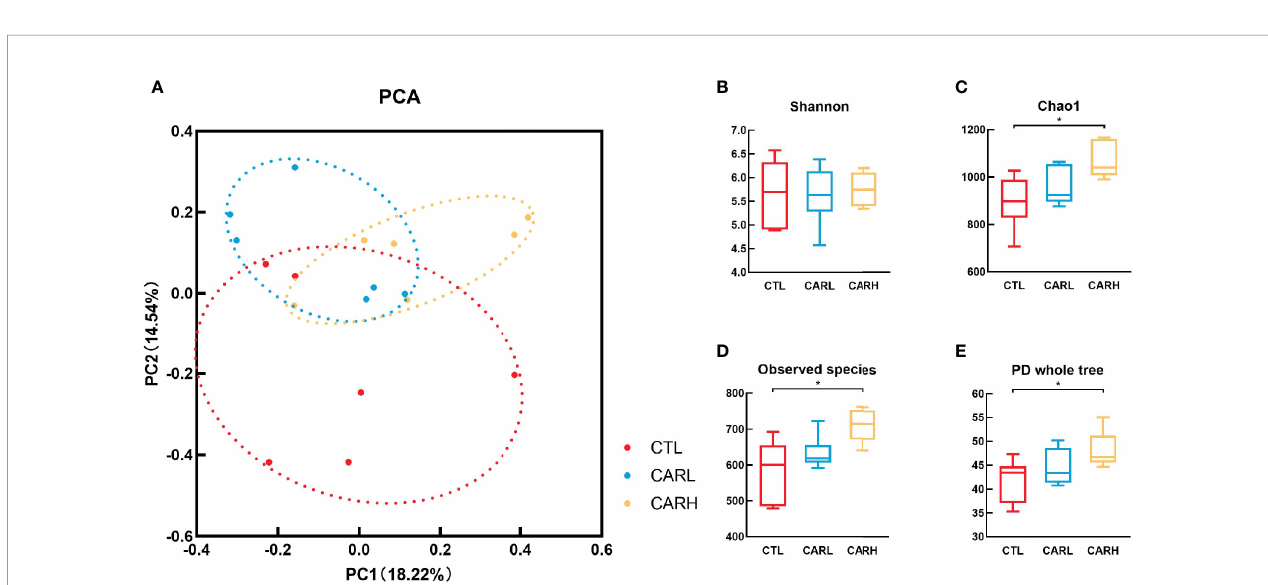
FIGURE 2 | The effect of b -carotene on gut morphology. Representative images of ileum mucosa section stained by hematoxylin and eosin (H&E) (A) , villus height and crypt depth of ileum (B) , ratio of villus height to crypt depth (C) were analyzed. CTL, a basal diet; CARL, a basal diet containing 30 mg/kg b -carotene; CARH, a basal diet containing 90 mg/kg b -carotene. Data were shown as means ± SD (n = 9). * P <